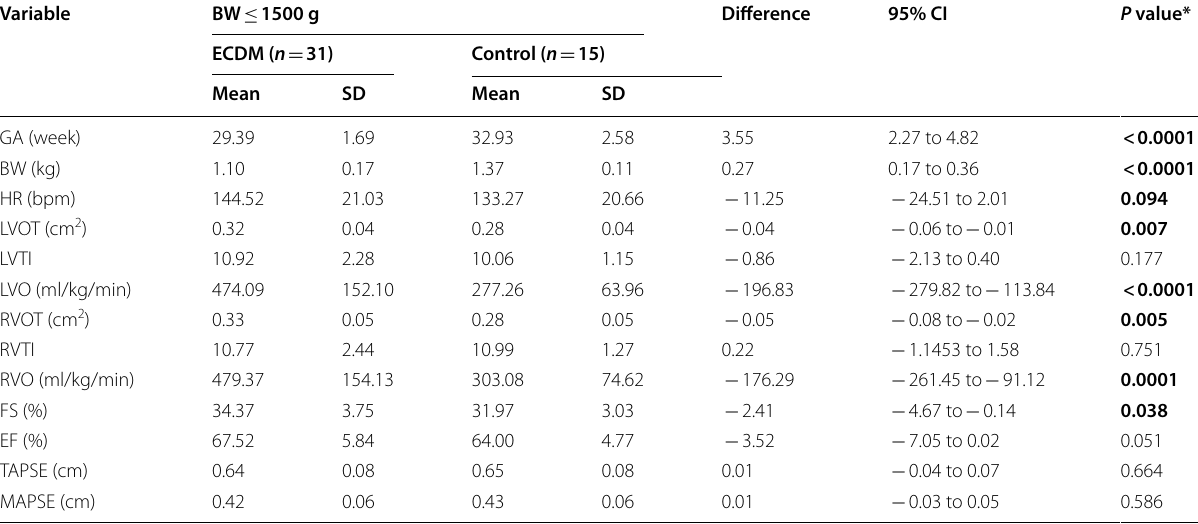
Table 2 Comparison of echocardiography‑directed management (ECDM) and control groups in the cohort of patients with birth weight 1500 g at ≤